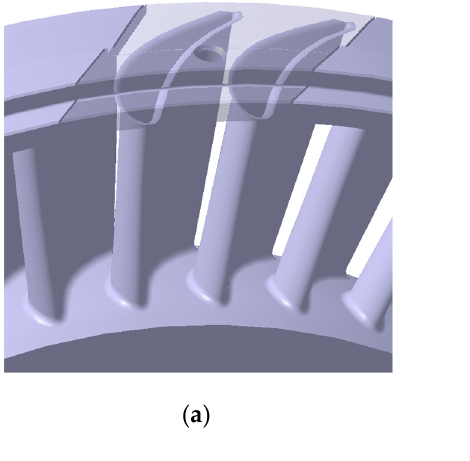
Figure 2. ( a ) Reference turbine vane profiles; ( b ) Reference turbine rotor blade profiles; ( c ) reference turbine assembly. Table 1. Reference turbine main parameters.